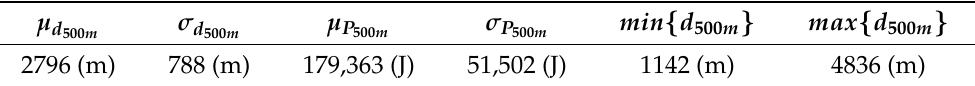
Table 7. Mean µ and standard deviation σ of 500 m flight corridor solutions.